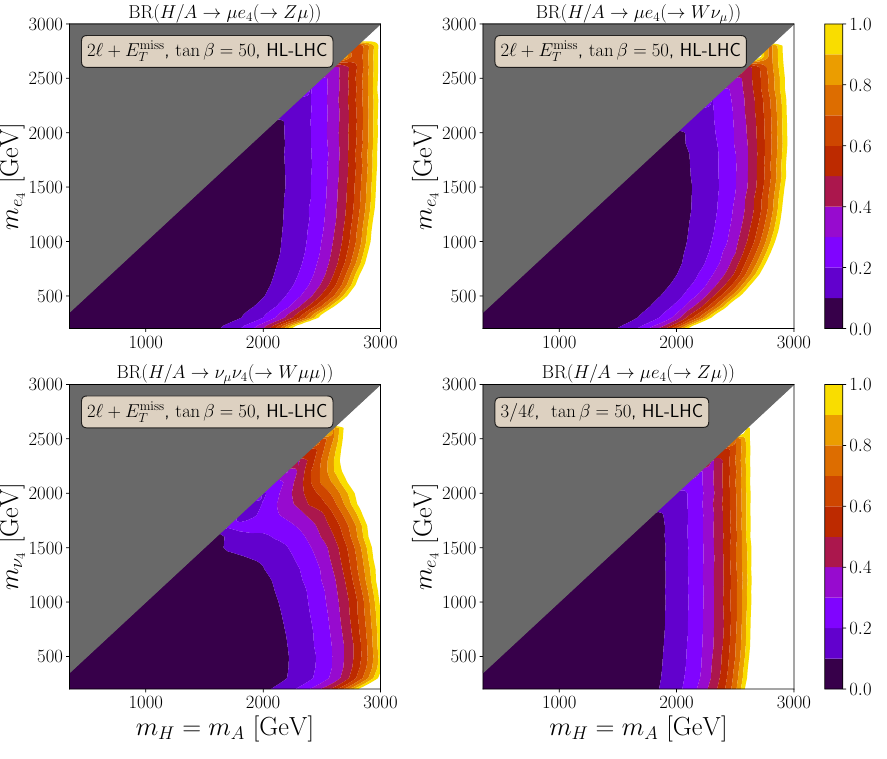
Figure 11 . Future upper bounds on the branching fractions when tan β = 50